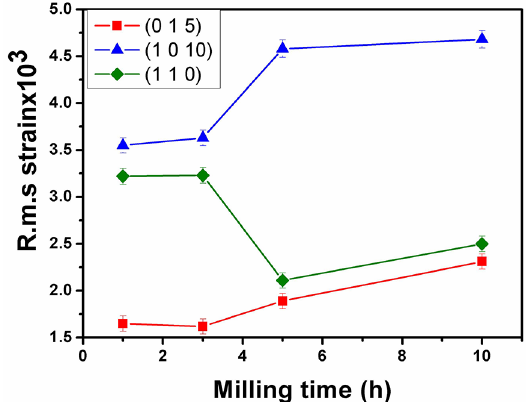
Figure 5. Variation of r.m.s. strains of Bi2Te3 phase with increasing milling time.